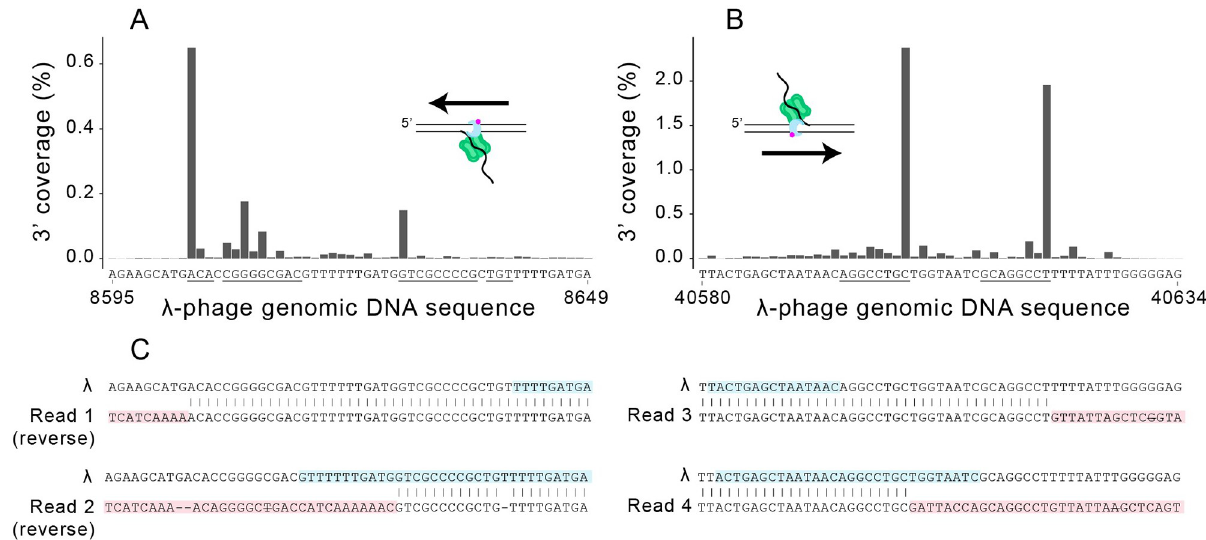
Fig 5. Inverted repeats are sites for template switching. (A) 3’ Coverage over the region 8695–8649 in the reaction with Nb.BbvCI. Strand displacing polymerization may only be initiated from the right. (B) 3’ Coverage over the region 40580–40634 in the reaction with Nb.BssSI. There are nicking recognition sequences on both sides of this region, but polymerization is principally initiated from the left. (C) Selected reads showing template switching. Representations of the full alignments for selected reads are shown in S5 Fig in S1